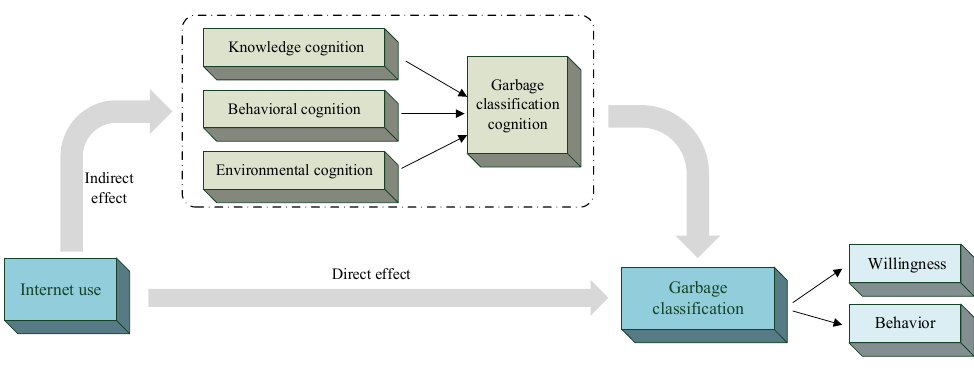
Figure 1. Theoretical mechanism diagram.